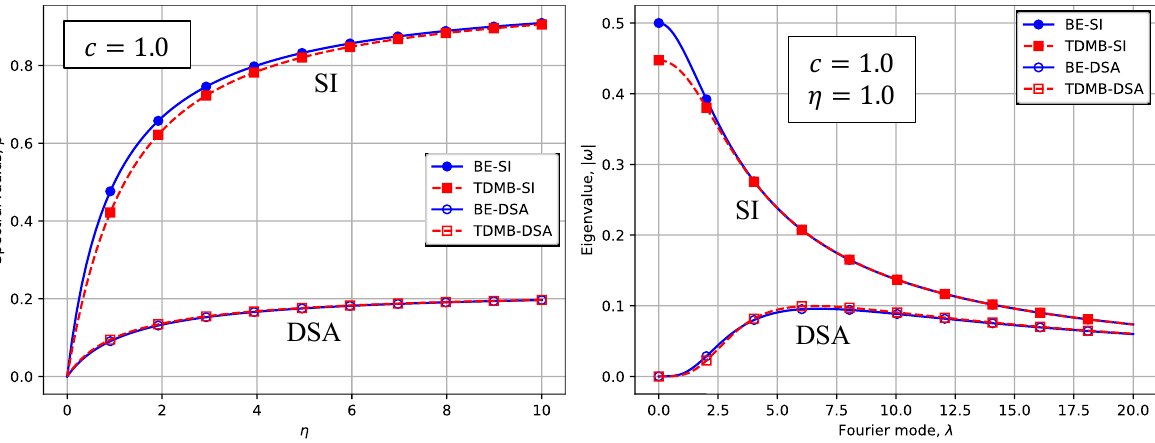
Figure 2. (Color online) Spectral radius (left) and eigenvalues (right) of SI and DSA. Eigenvalues of TDMB are complex conjugate pairs, and the curves shown on the right figure are their